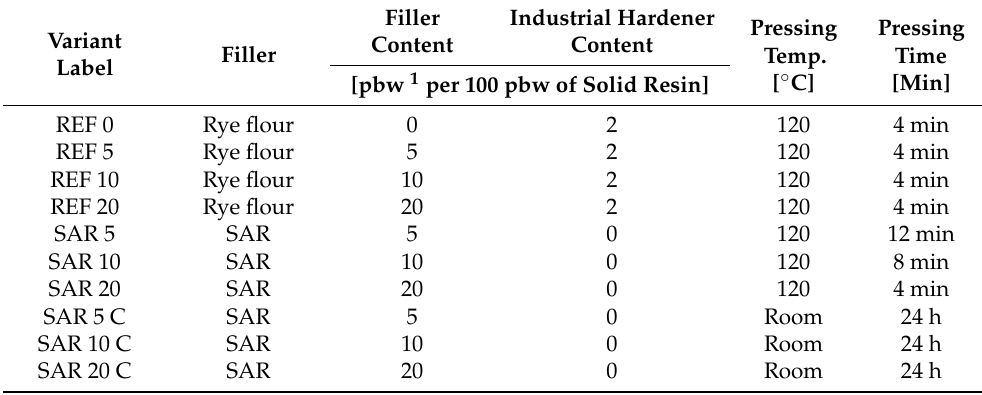
Table 1. Compositions of bonding mixtures and plywood-selected pressing parameters.